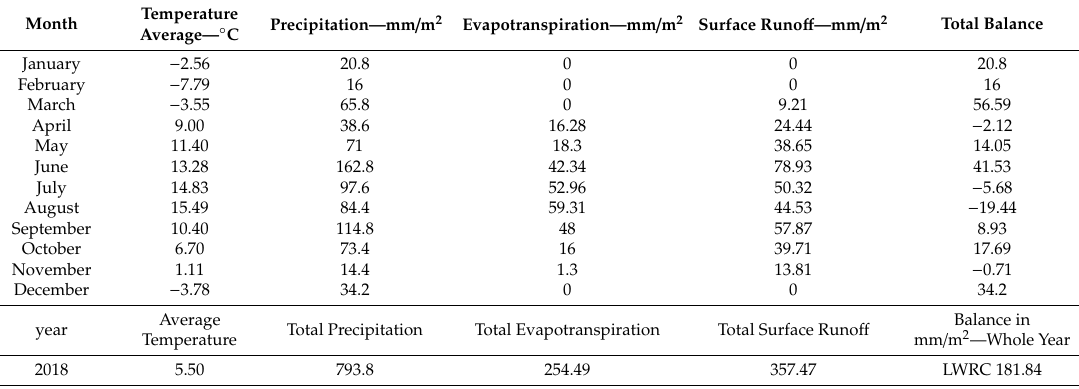
Table 4. Hydrological balance for 2018 in the test